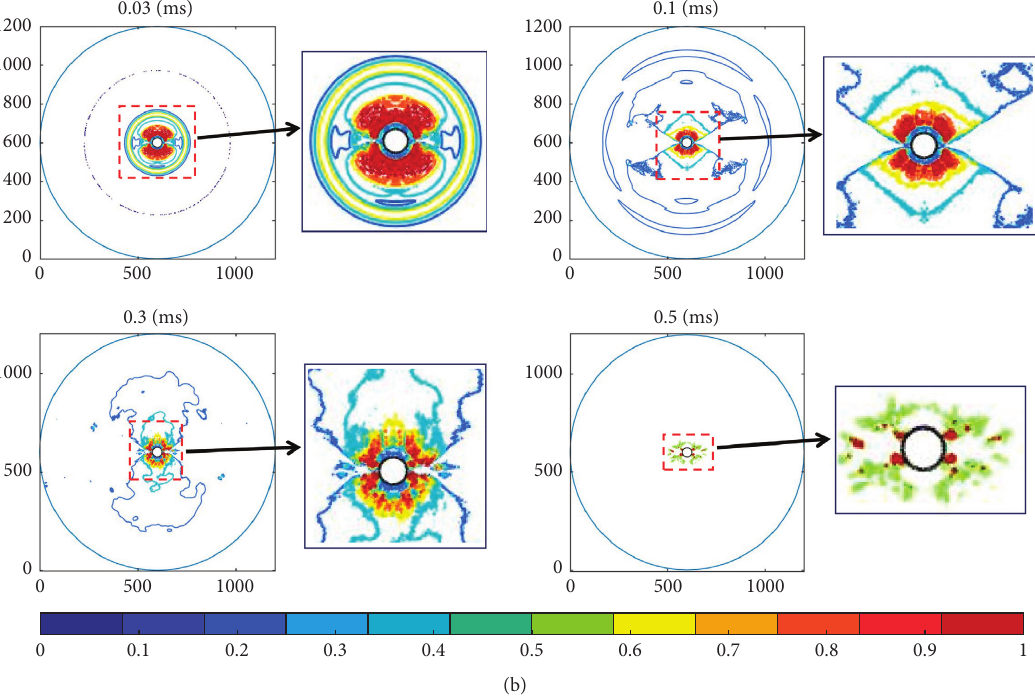
Figure 9: Damage evaluation and effective stress evaluation for 45 ° shaped energy angle blasting. (a) Development process of 45 ° shaped energy angle blasting damage. (b) The development process of equivalent stress of 45 ° shaped energy angle